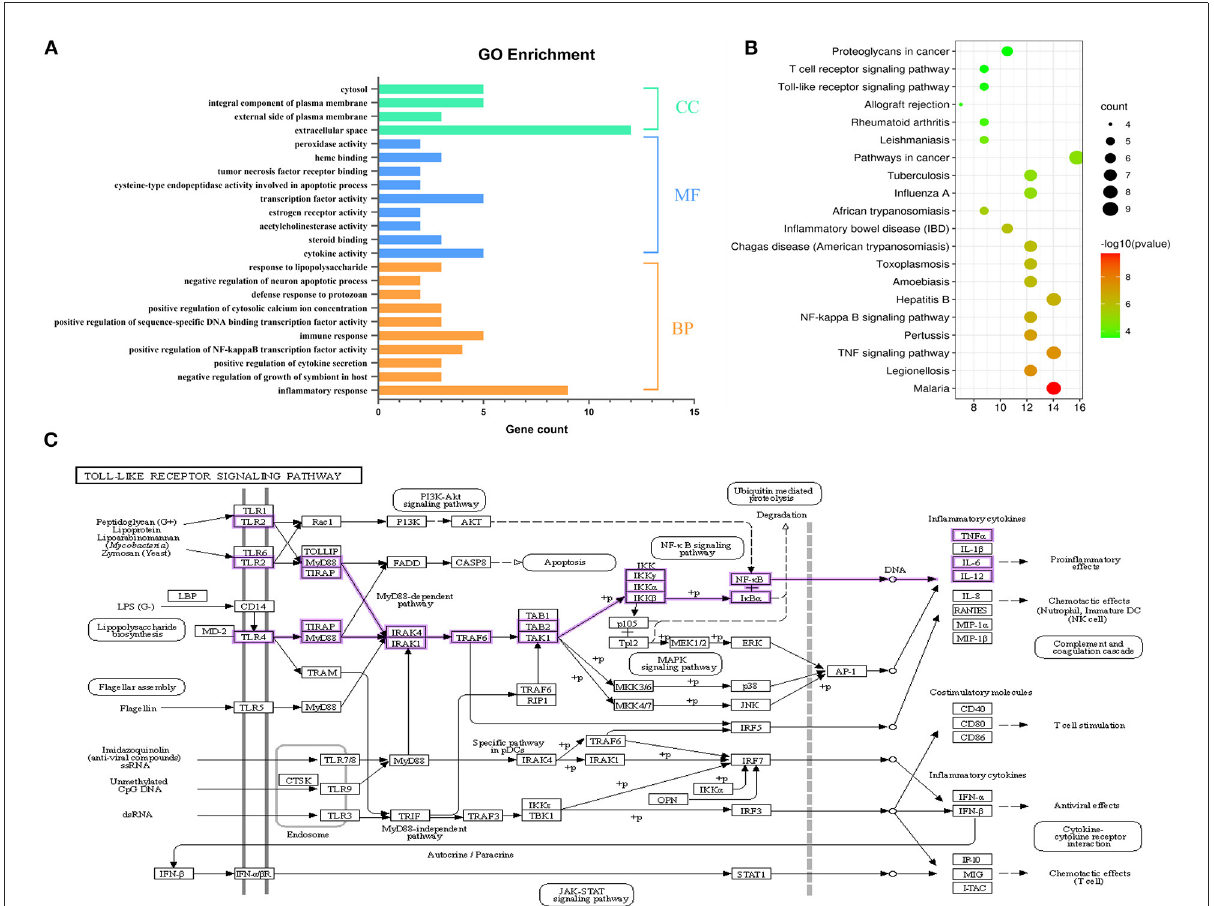
FIGURE4 Functional enrichment analysis. (A) GO annotation of SOL components acting on the target of endometritis. (B) The top 20 KEGG pathway enrichment analysis of key targets. The color scale indicates the p -value, and the dot size represents the gene count in each term. (C) Pathway diagram of Toll-like receptor signaling